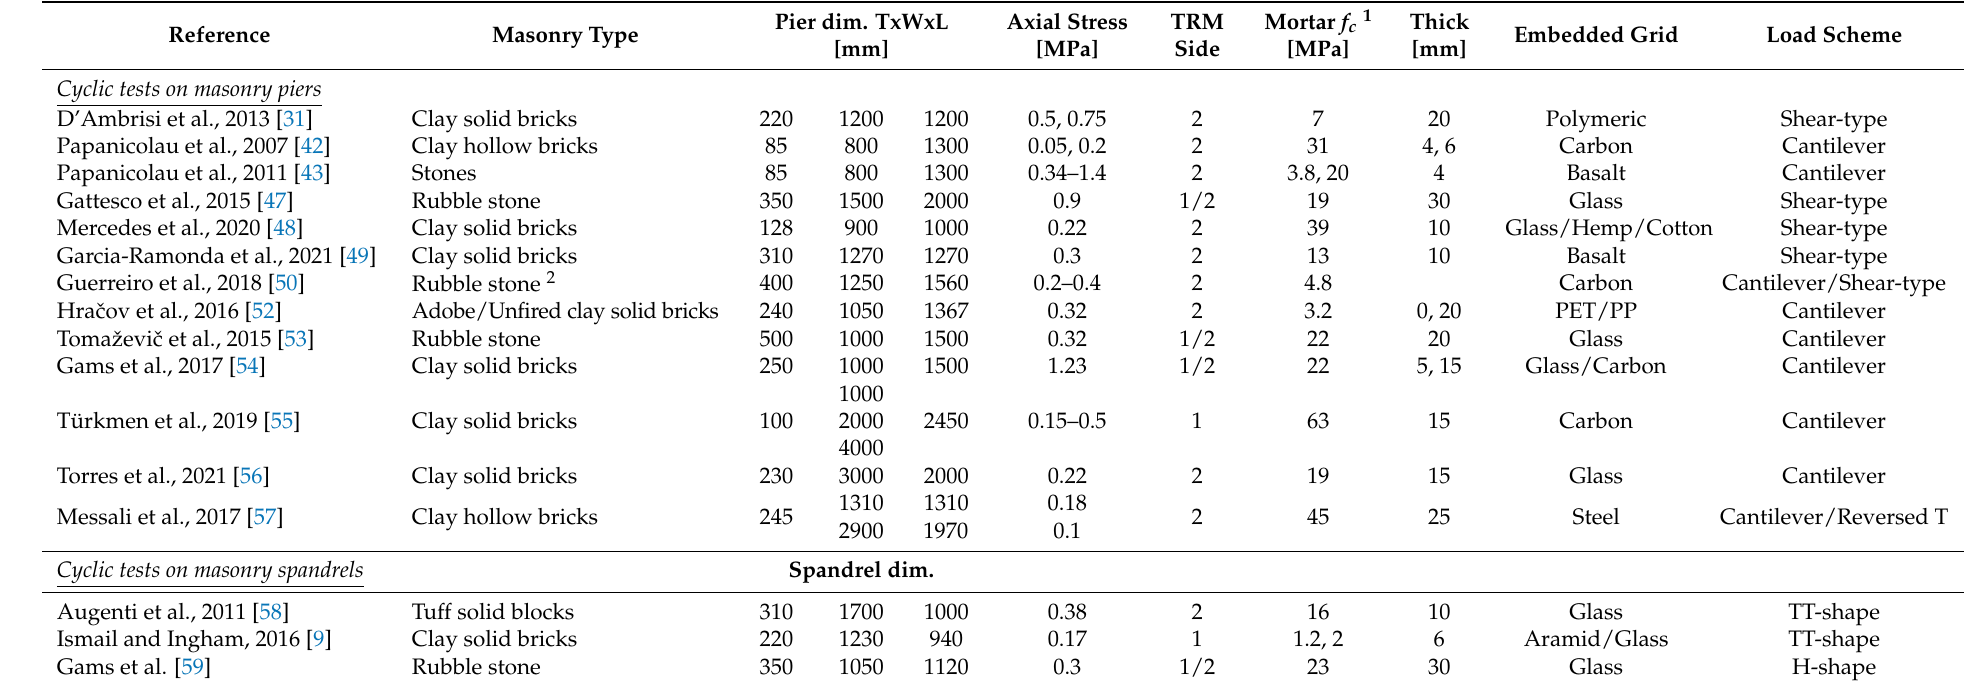
Table 2. Summary of experimental in-plane cyclic tests on masonry piers and